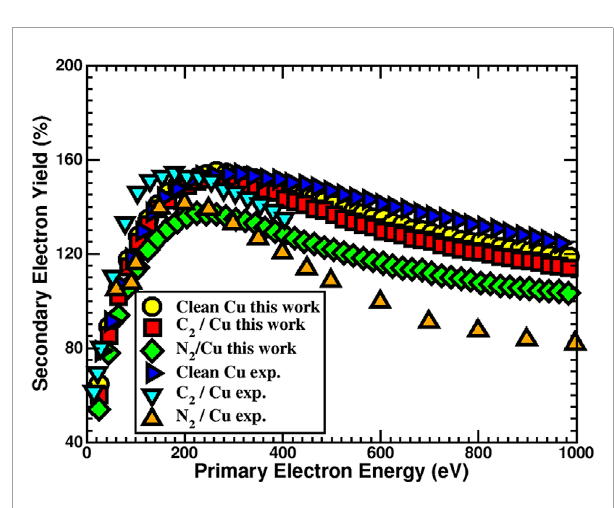
FIGURE 3 Calculated secondary electron yield for the clean Cu (110), C 2 /Cu (110), and N 2 /Cu (110) surfaces and their comparison with 1.00 ML coverages. Experimental measurements for C 2 /Cu (Larciprete et al., 2013) and N 2 /Cu (Kuzucan, 2011; Kuzucan et al., 2012) systems are provided for comparison.